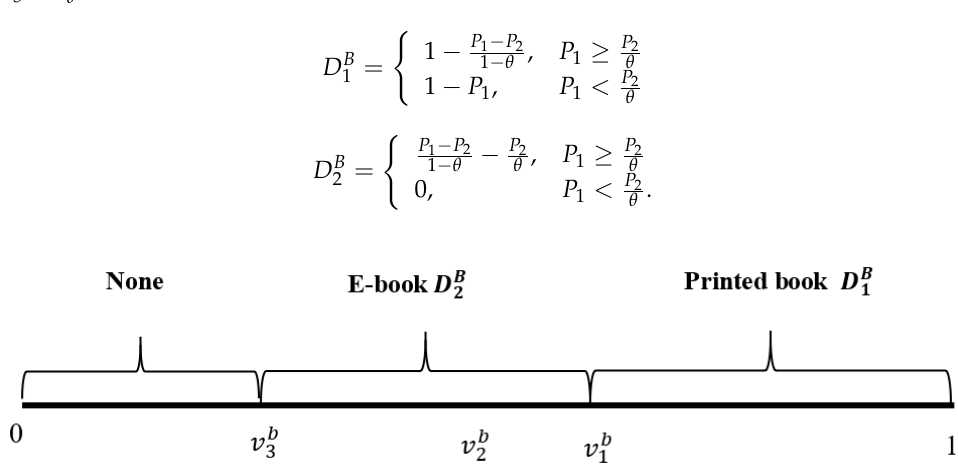
Figure 2. Market Segmentation of the Benchmark Model when P 1 ≥ P 2 The retailer profit function is given as: